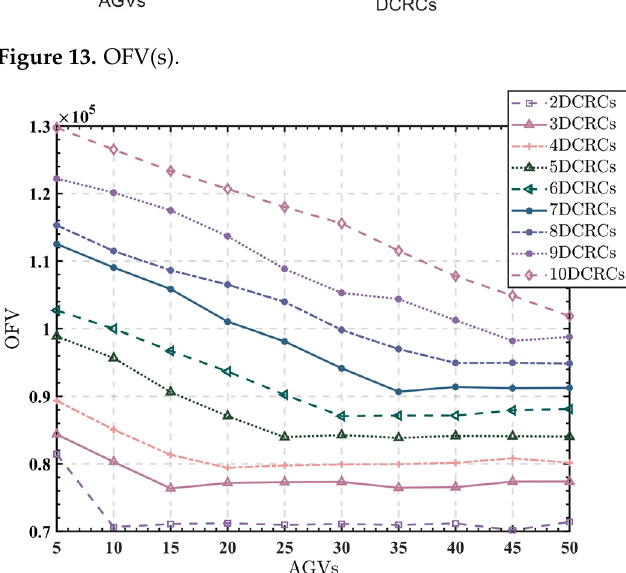
Figure 14. OFV at 1 QC. Figure 14. OFV at 1